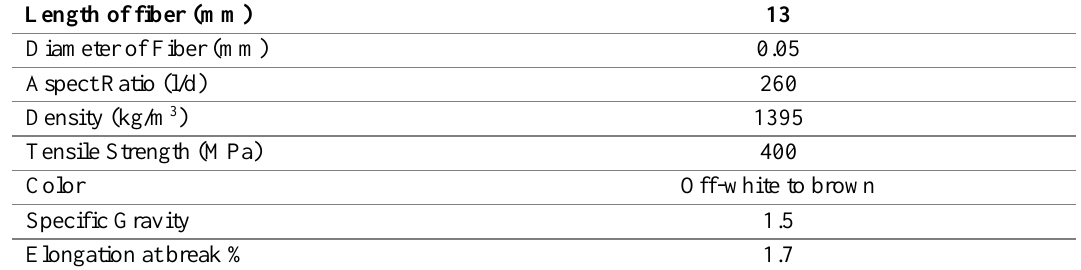
Characteristics of the jute fiber used in the research (textile engineering study, 2012). Length of fiber (mm)